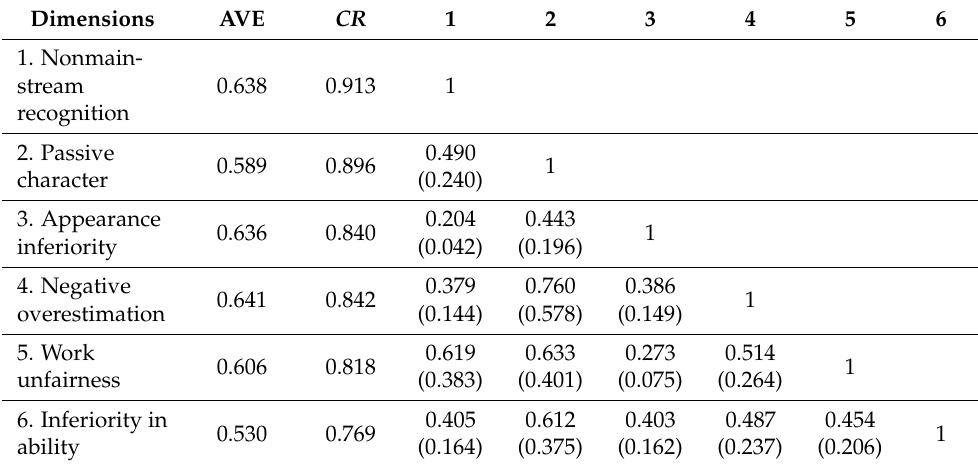
Table 7. Correlation results between latent variables.